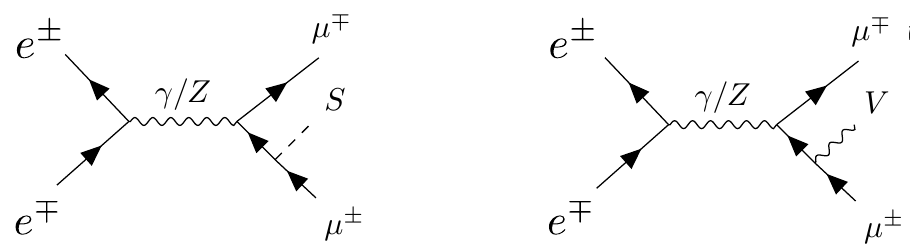
Figure 5 . Representative Feynman diagrams that yield singlet scalar (left) and vector (right) production at a B -factory via e + e − annihilation. The BABAR and Belle II search strategies discussed in section 4 involve the 4 µ channel in which S/V → µ + µ − decays yield 4 µ final states with an opposite-sign di-muon resonance that reconstructs the singlet’s